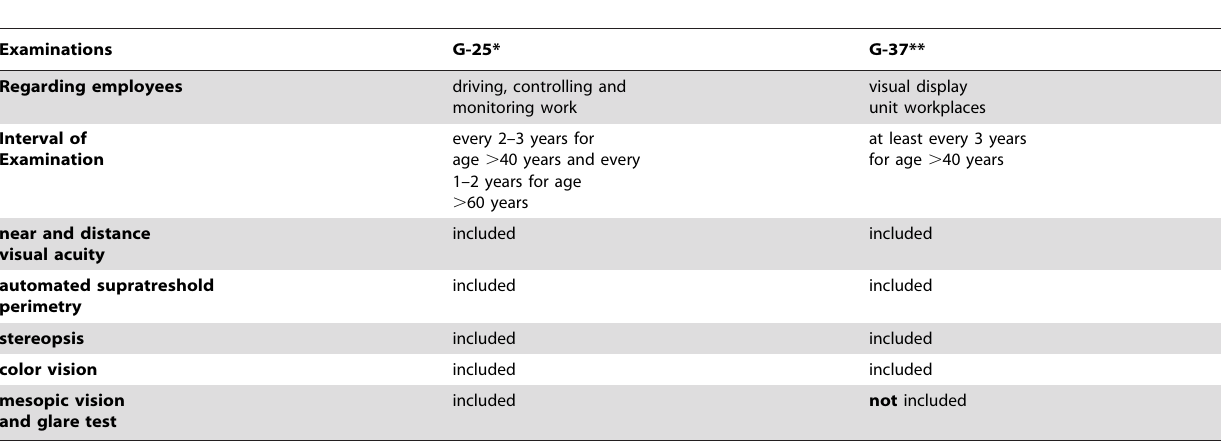
Table 1. Ophthalmological examinations within occupational health supervision in